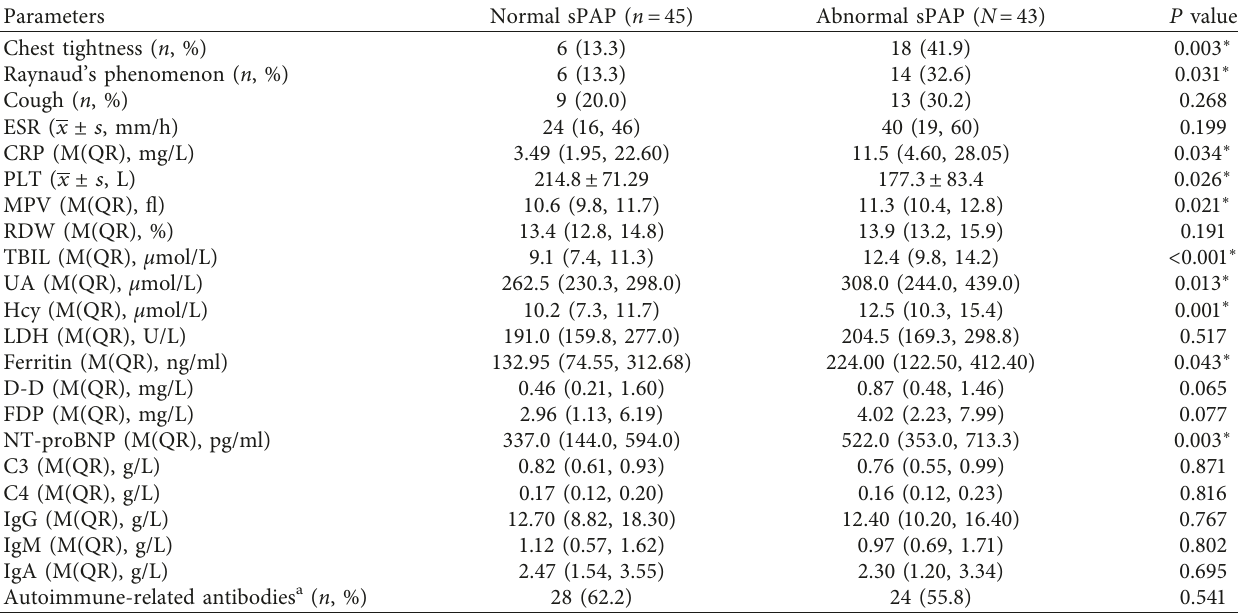
Table 1: Baseline clinical data of CTD patients.